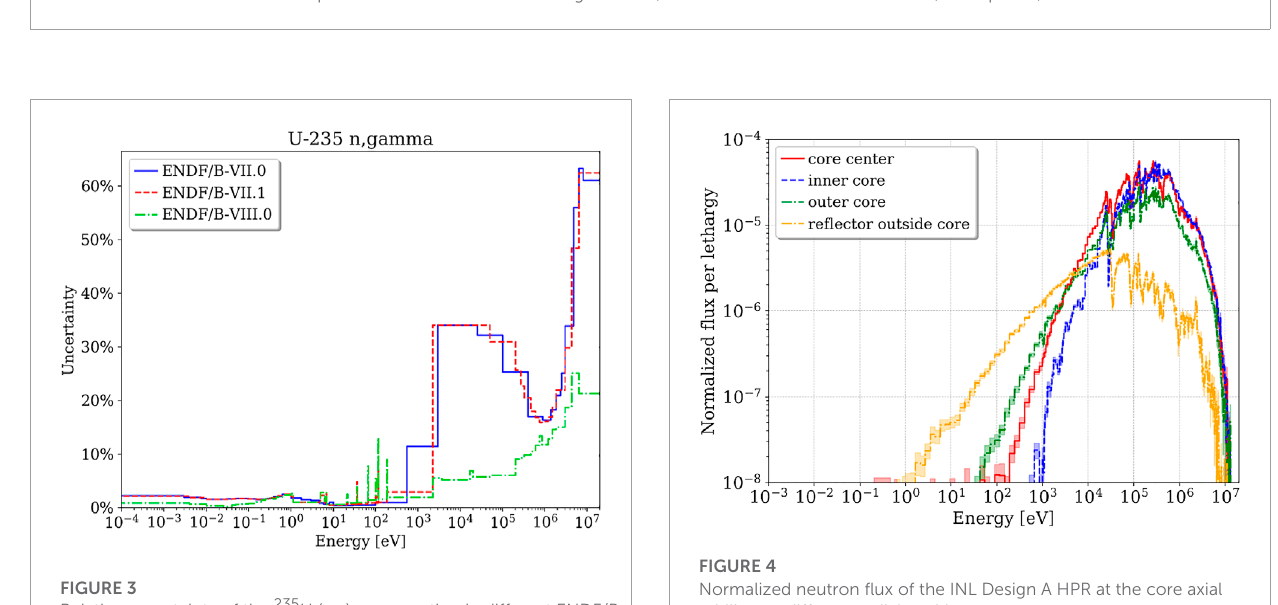
FIGURE 2 Relative contributions to the output uncertainties of the INL Design A HPR (as obtained with TSUNAMI in Δ R/R, R: response).